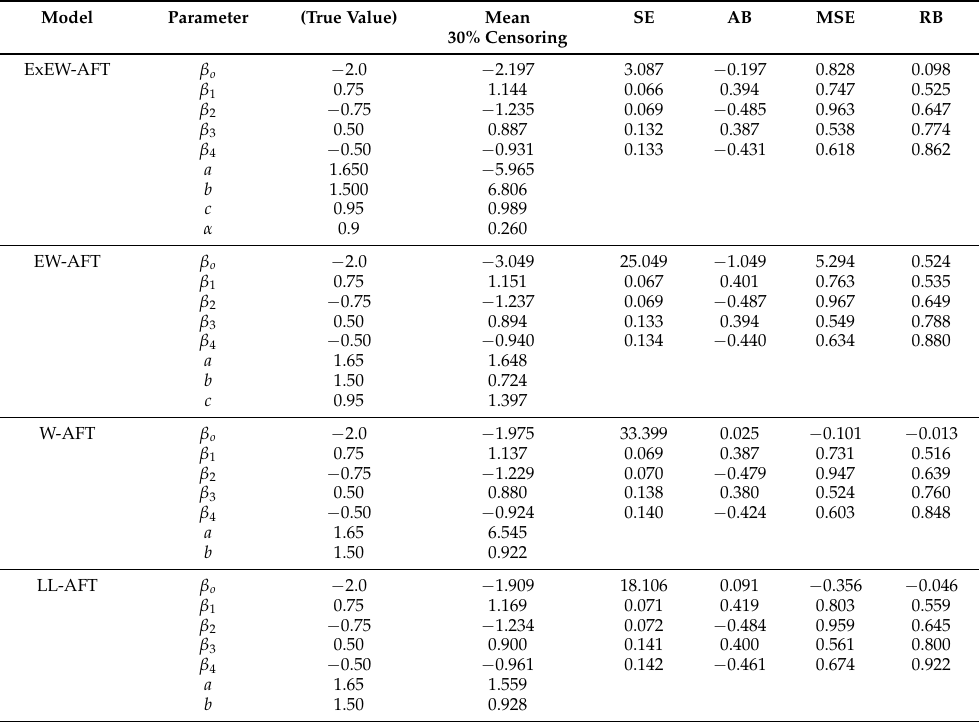
Table 15. Simulation study for Scenario 4 ( n = 1000) with about 30% censored observations is used to compare model performance.